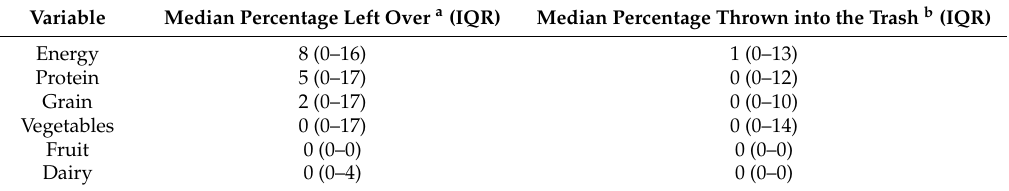
Table 3. Percentage of energy and food groups left over and percentage thrown into the trash at lunch 86 girls nine to thirteen years living in O’ahu, Hawai’i who participated in the study and completed an acceptable mobile food